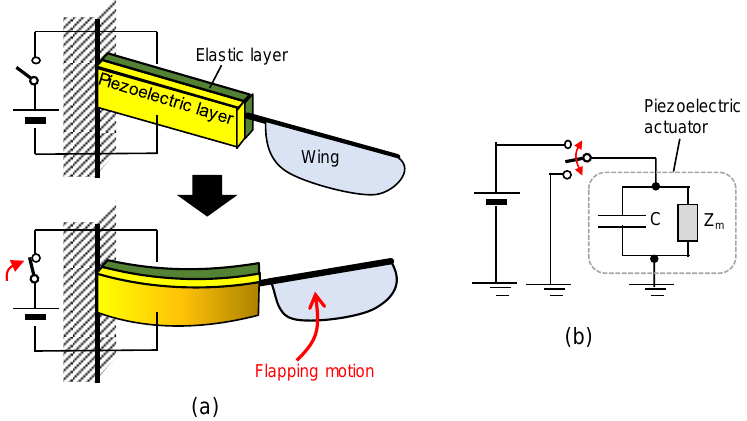
Figure 1. Piezoelectric flapping-wing actuator and its basic driver circuit: ( a ) principle of piezoelectric actuation; ( b ) a driver circuit with simple switch.